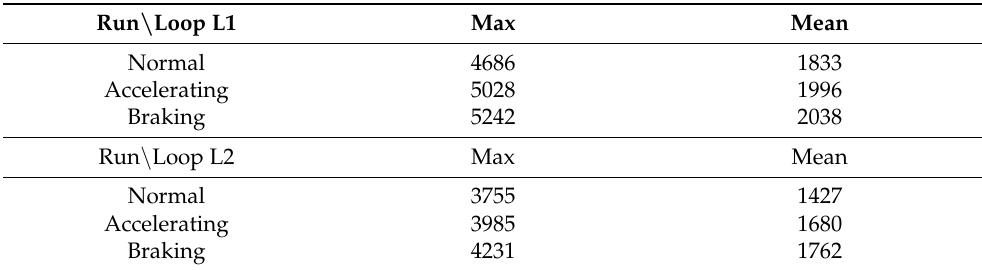
Table 11. Signal characteristics from inductive loops—amplitude and mean signal value